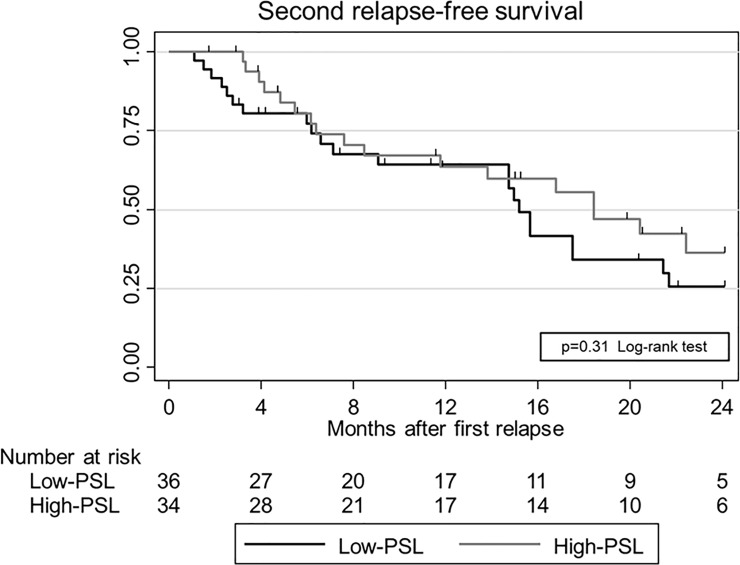
Second relapse-free survival of minimal change disease after first relapse.Second relapse-free survival after first relapse in the High-prednisolone (PSL) group (n = 34) and Low-PSL group (n = 36) were calculated using the Kaplan–Meier method and compared by log-rank test. Abbreviations: MCD, minimal change disease; PSL, prednisolone.